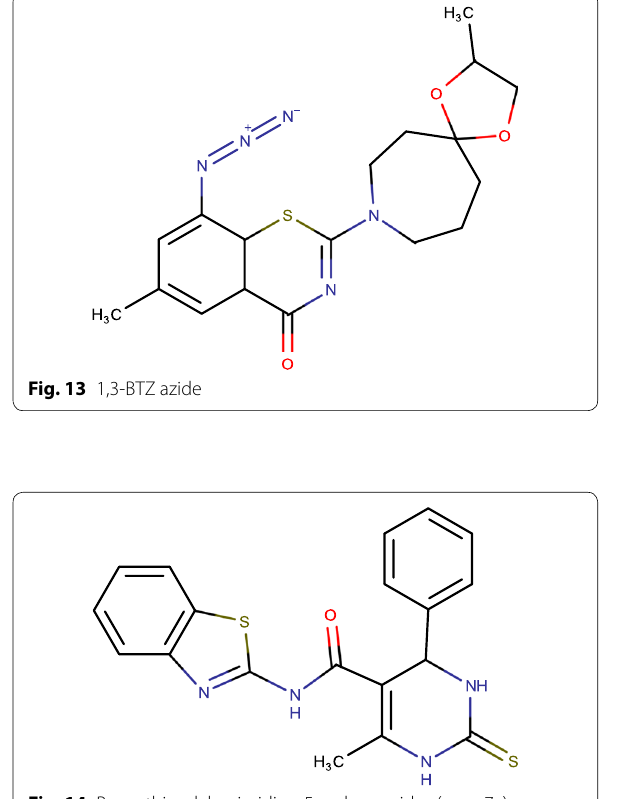
Fig. 14 Benzothiazolylpyrimidine-5-carboxamides (cmp-7a)